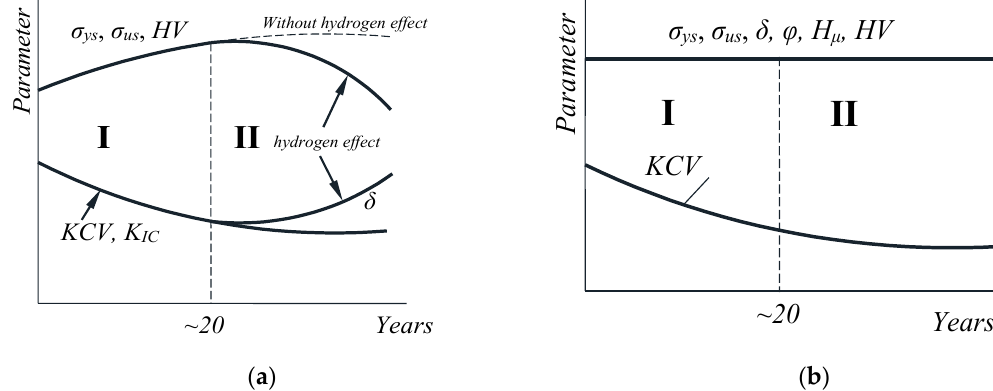
Figure 1. A generalized scheme of the gas main steel degradation: ( a ) In moderate climate conditions (Ukraine) [8]; ( b ) in conditions of the Far North (Yakutia, Russia) [12]; KCV —impact toughness; K IC —fracture toughness; σ us —ultimate strength; σ ys —yield stress; HV —hardness; H μ —microhardness; δ —relative elongation; φ — relative narrowing.